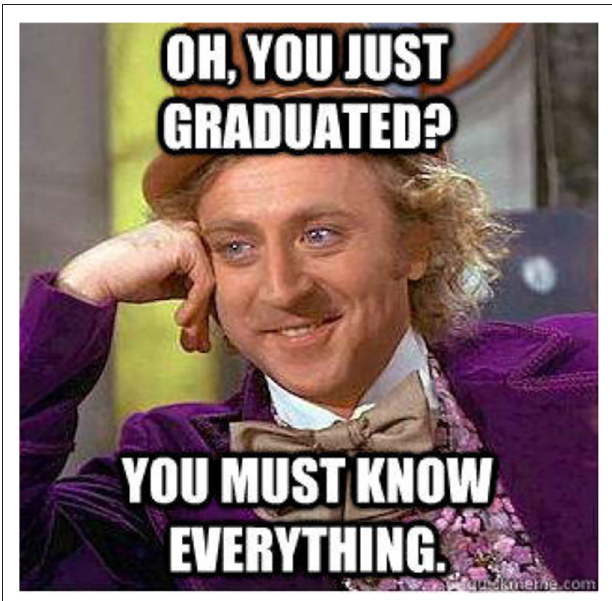
FIGURE 1 | An example of the Condescending Wonka